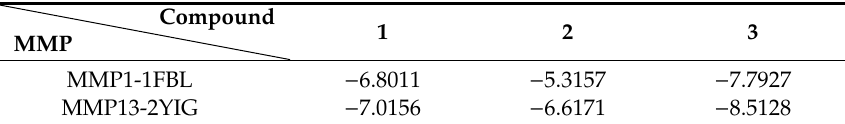
Table 1. Binding energy of compounds 1 – 3 (kcal /